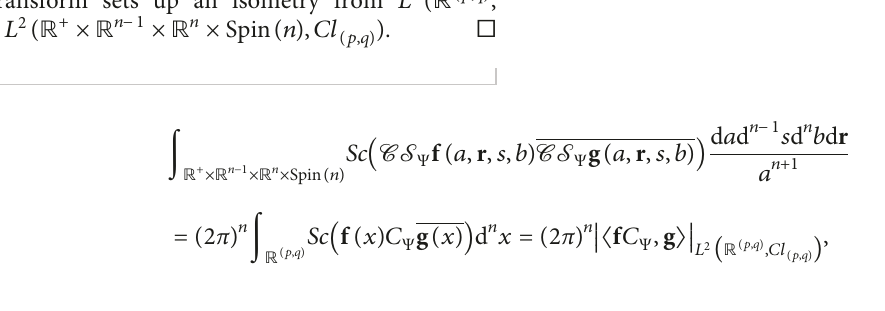
Figure 1: Two-dimensional analyzing shearlets ψ r a � 1, b � 1, and s � 0. (b) Contour plot of 2D-shearlets at a � 1, b � 1, and s � 0. (c) 2D-shearlets at a � 1/2, b � 1 and s � 1. (d) Contour plot of 2D-shearlets at a � 1/2, b � 1 and s �